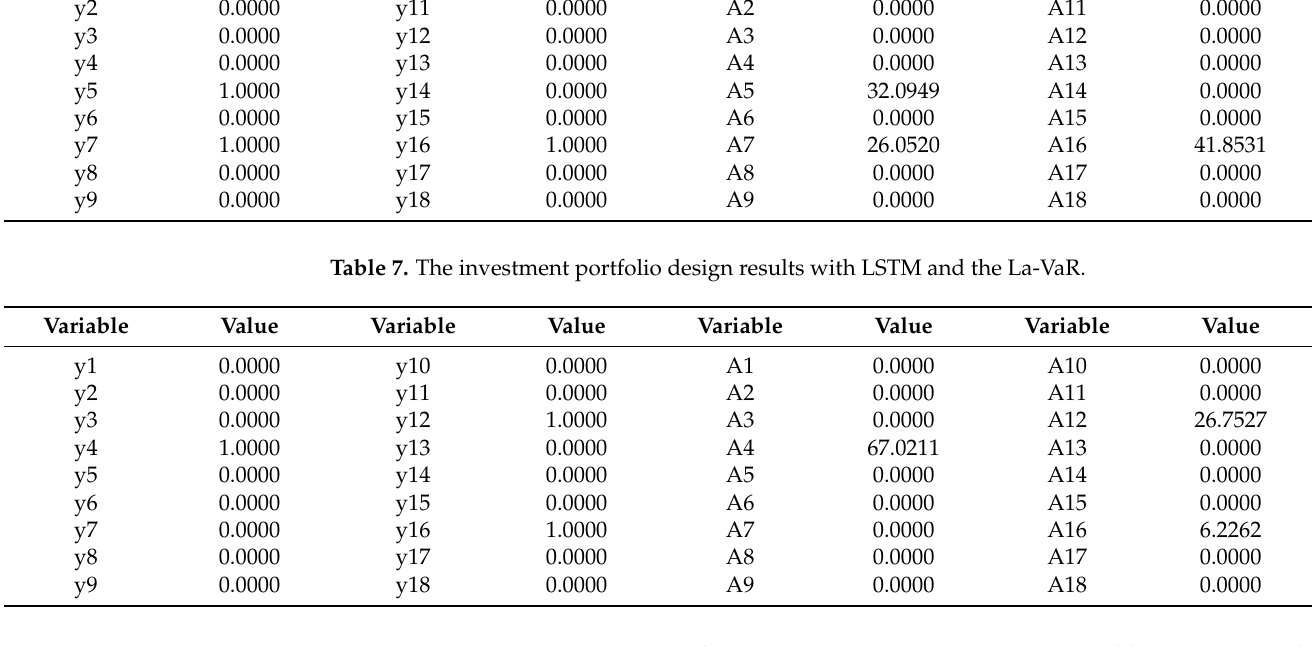
Table 6 indicates that the portfolio should invest RMB 320,949 in the fifth IMF